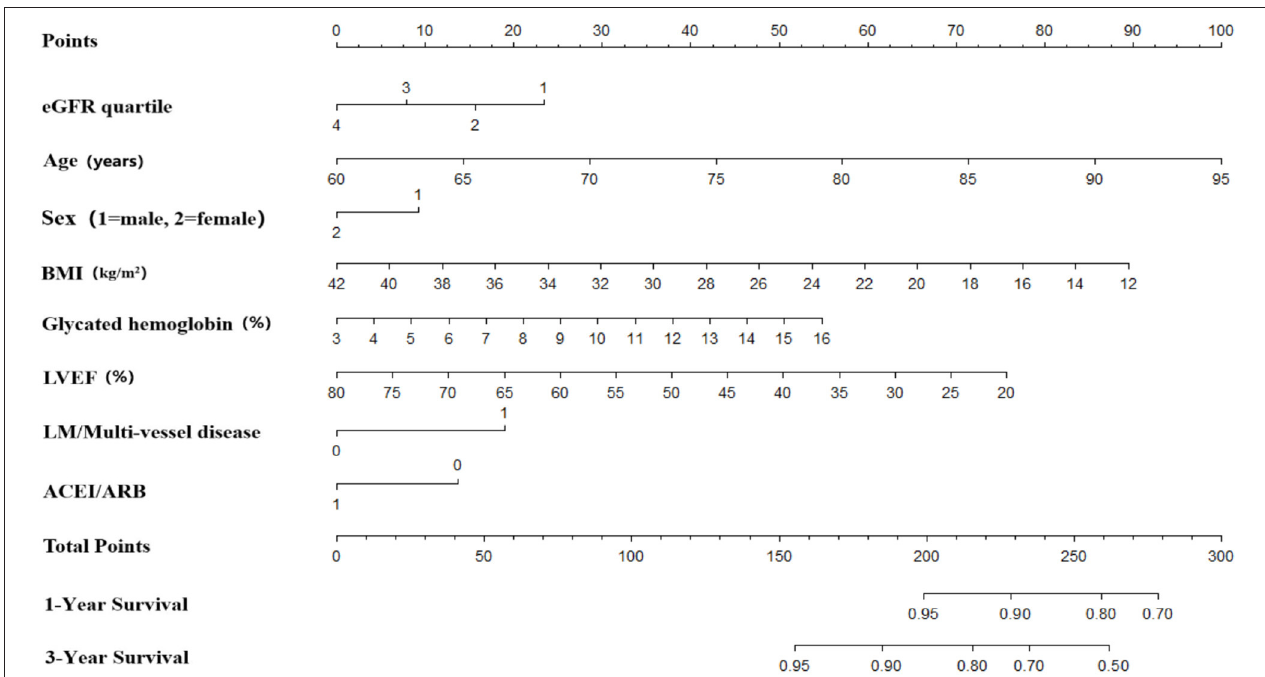
FIGURE 2 | Instructions for Using the Nomogram. Draw a line perpendicular from the corresponding axis of each risk factor until it reaches the top line labeled “Points.” Sum up the number of points for all risk factors then draw a line descending from the axis labeled “Total Points” until it intercepts each of the survival axes to determine 1- and 3-year survival probabilities. For eGFR quartile, 1 = Quartile 1 (eGFR ≤ 63.02 ml/min/1.73 m 2 ), 2 = Quartile 2 (eGFR 63.03–78.45 ml/min/1.73 m 2 ), 3 = Quartile 3 (eGFR 78.46–91.50 ml/min/1.73 m 2 ), 4 = Quartile 4 (eGFR > 91.51 ml/min/1.73 m 2 ). For sex, 1 = male and 2 = female. For LM/Multi-vessel disease, 0 = no and 1 = yes. For ACEI/ARB, 0 = no use and 1 = use. eGFR, estimated glomerular filtration rate; BMI, Body Mass Index; LVEF, left ventricular ejection fraction; LM, LM, left main coronary artery; ACEI or ARB, angiotensin-converting enzyme inhibitor/angiotensin receptor blocker.